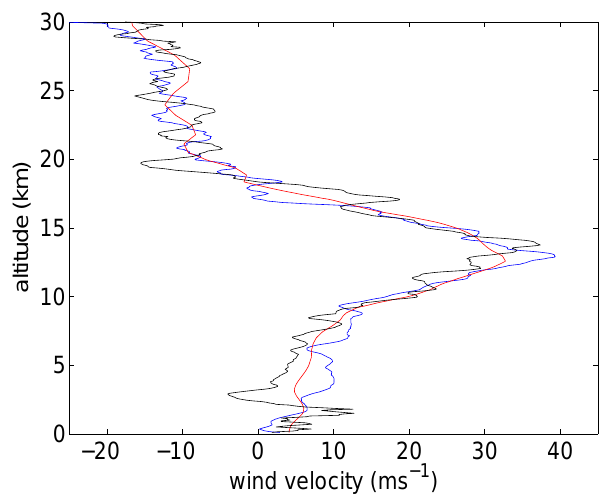
Fig. 13. High-resolution radiosonde zonal-wind profile (blue) ver- sus ECMWF model background from a 12-h forecast (red). The black profile is the adapted model profile, see the text for details.